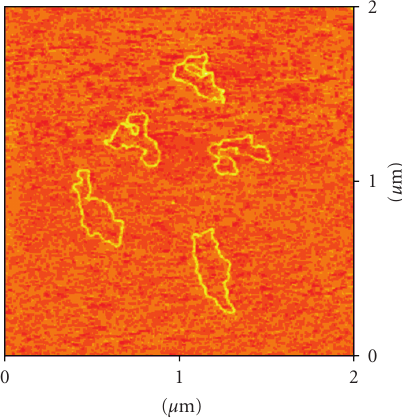
Figure 6: AFM image of the plasmid pBR322 DNA incubated with the complex [RuCp(PPh 3 ) 2 (Tvt)][PF 6 ] 4 r i = 0.5.